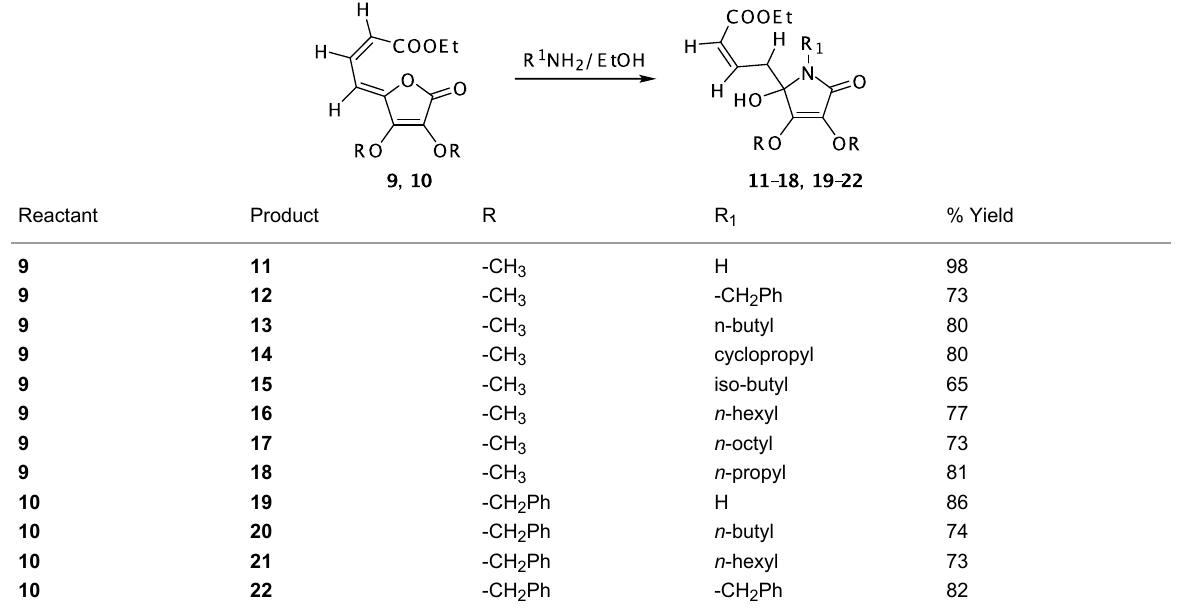
Table 2: Synthesis of dienyl tetramic acid derivatives from 5-hydroxy lactams